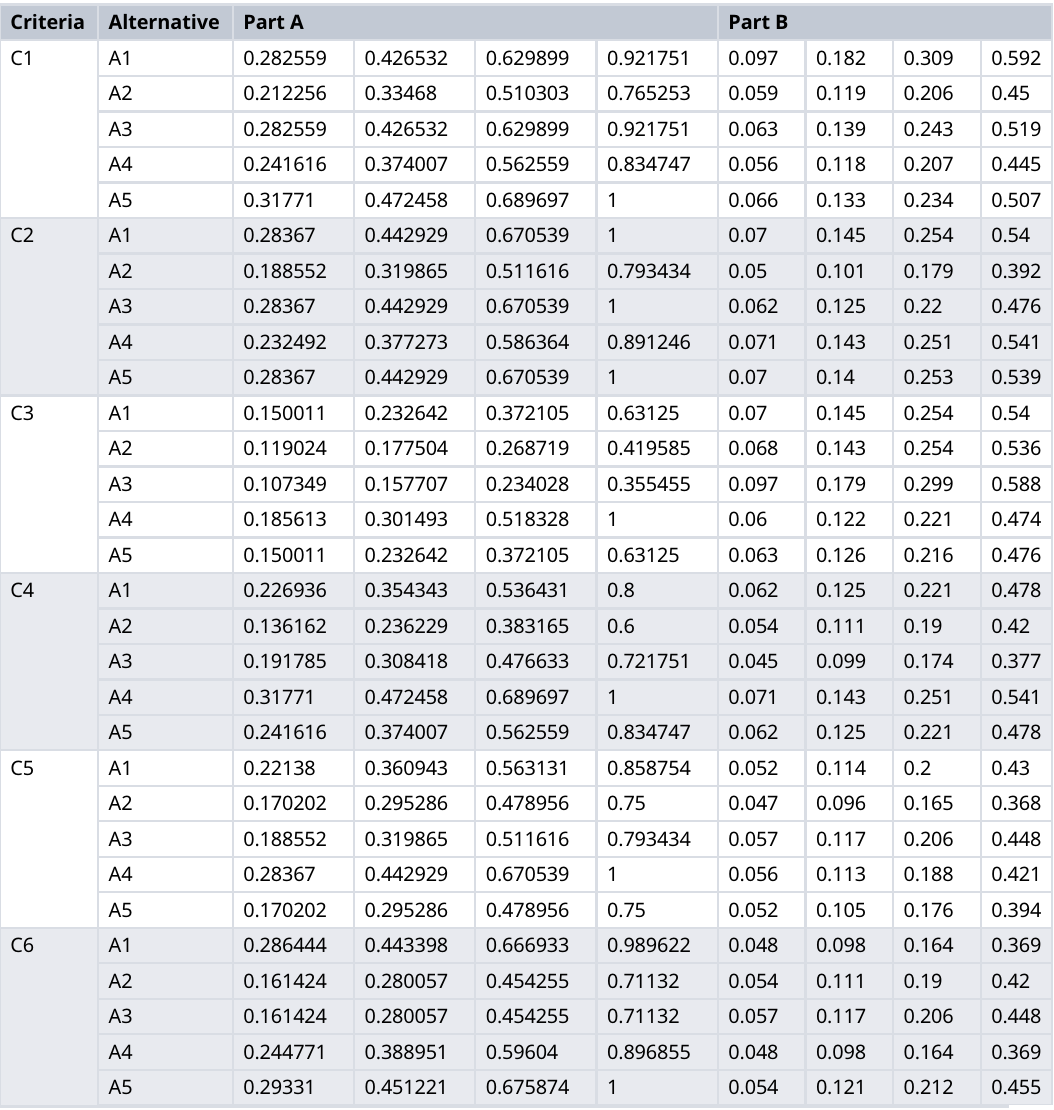
Table 5. Z-number based normalized decision